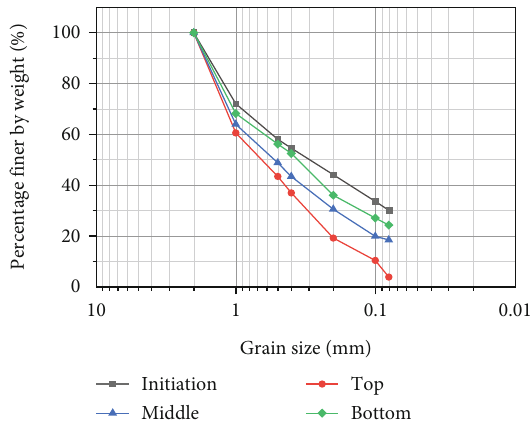
Figure 8: Test number 1 particle grading variation curves before and after